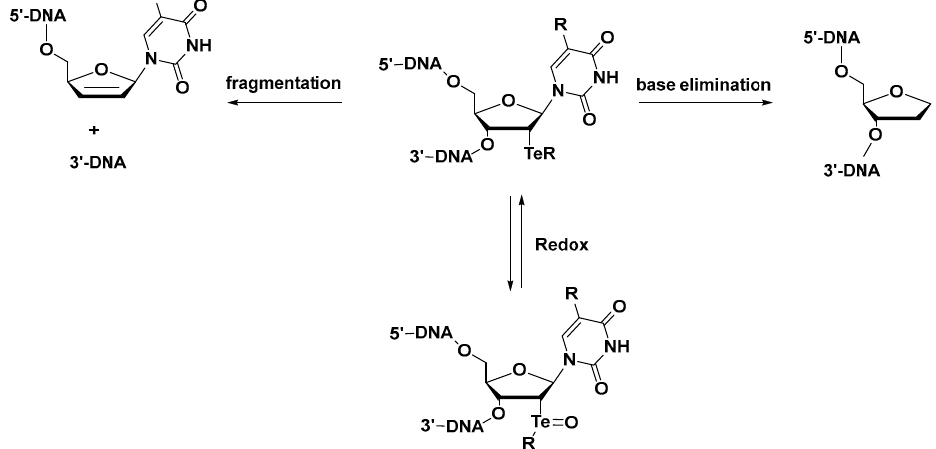
Figure 1. UV melting curves of DNA duplexes (5 ′ -C(TeXU)TCTTGTCCG-3 ′ and 3 ′ -CGGACAA- GAAG-5 ′ ; X = Me or Ph). In 2011, 5-PhTe modified nucleoside was successfully synthesized by applying the lithium–halogen exchange reaction [142] on a protected 5-iodo-2 ′ -deoxyuridine and achieved medium yield (64%) [143] (Scheme 5). The key steps of the reaction are the deprotonation of the NH and the treatment with n-BuLi followed by the addition of Ph 2 Te 2 . An elevated concentration of the reactant (0.15–0.18 M) is necessary to avoid the generation of a 6-PhTe isomer, which is inseparable. The synthesis of the corresponding phosphoramidite followed the standard protocol and applied to solid-phase synthesis. The results show that the PhTe functionality is well compatible with the solid-phase syn- thesis condition, deprotection, and purification. The UV-thermal denaturation studies show similar stability between the Te-derivatized duplex and the corresponding native which suggested that the bulky PhTe moiety is well accommodated and does not signifi- cantly change the duplex structure (Figure 2). The Te-DNA crystal structure was also obtained by the same author by using 2 ′ -Se modification strategy [137–139,144]. The results reveal that Te-DNA has virtually identical